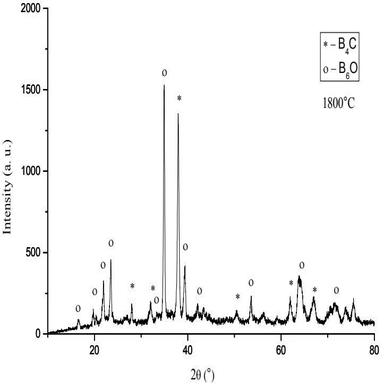
X-ray diffraction patterns of B6O sample after hot-press sintering at 1800°С.